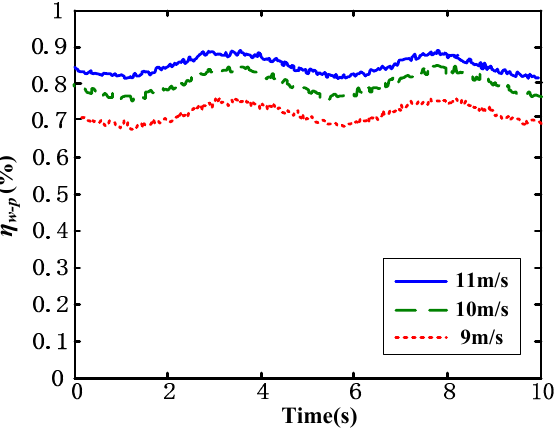
Figure 10. Efficiency experiment contrast curve of the wind-pump system under different wind speeds.